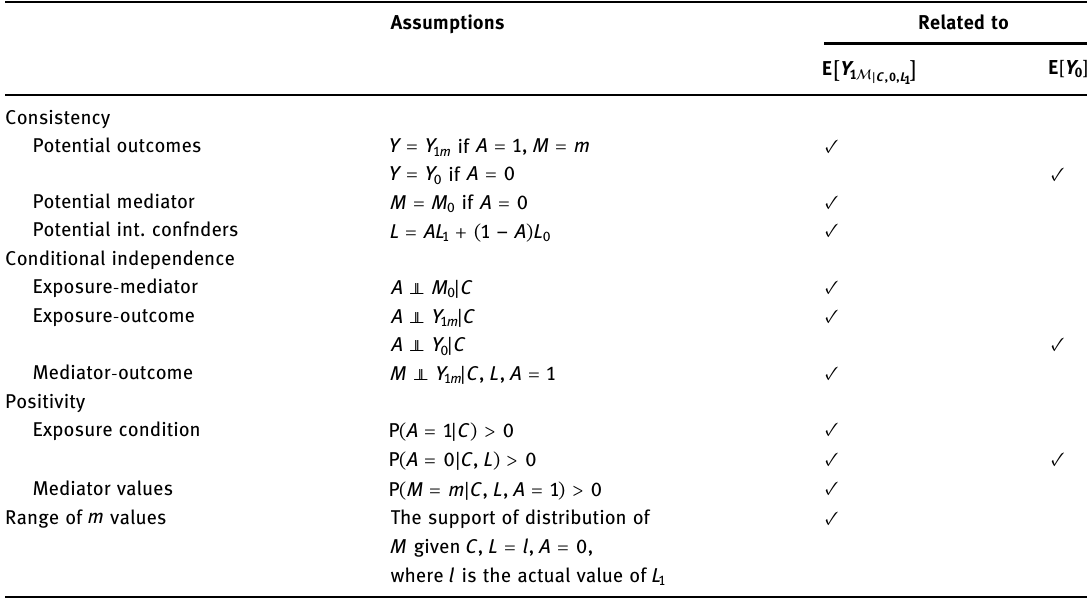
Table 8: Identifying assumptions for